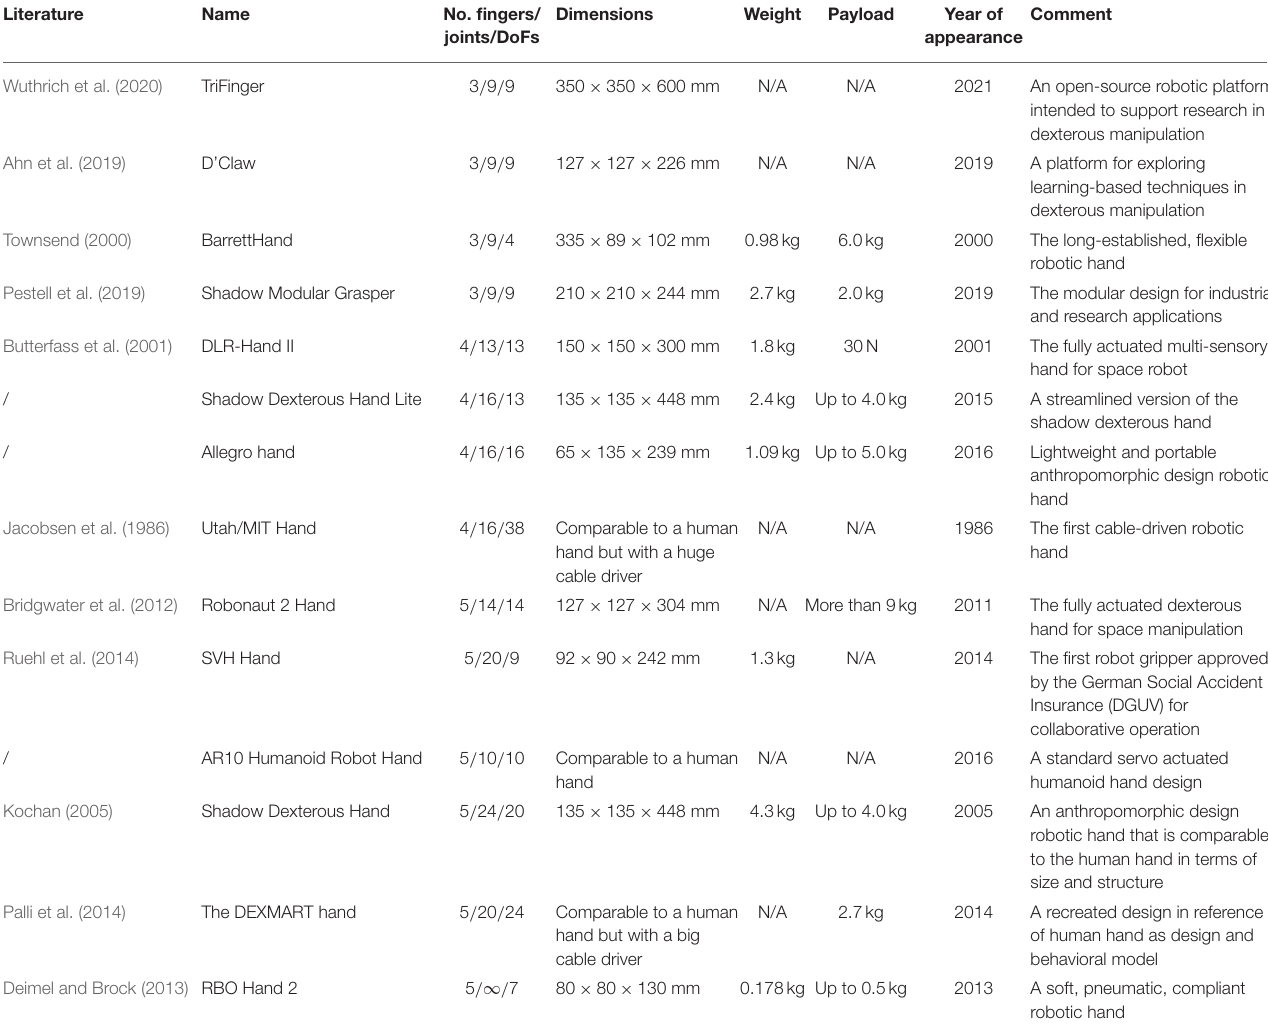
TABLE 3 | The technical details of the robotic dexterous